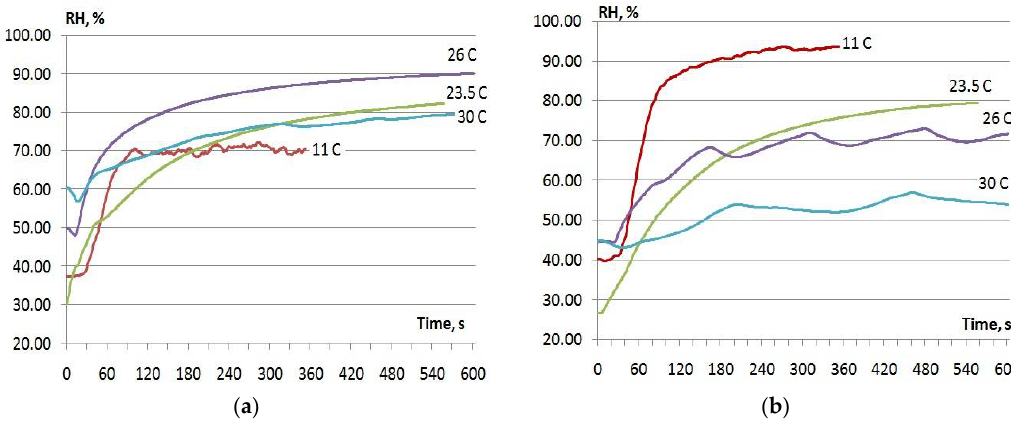
Figure 2. Dynamics of the humidity at the ‘ambient side’ of the membrane-containing fabric just above the fabric ( a ), and in the air above it ( b ). Wave-type changes in relative humidity happening after 2 min in 26 and 30 °C case are due to rather small changes in the air temperature caused by the inefficiency of temperature regulation